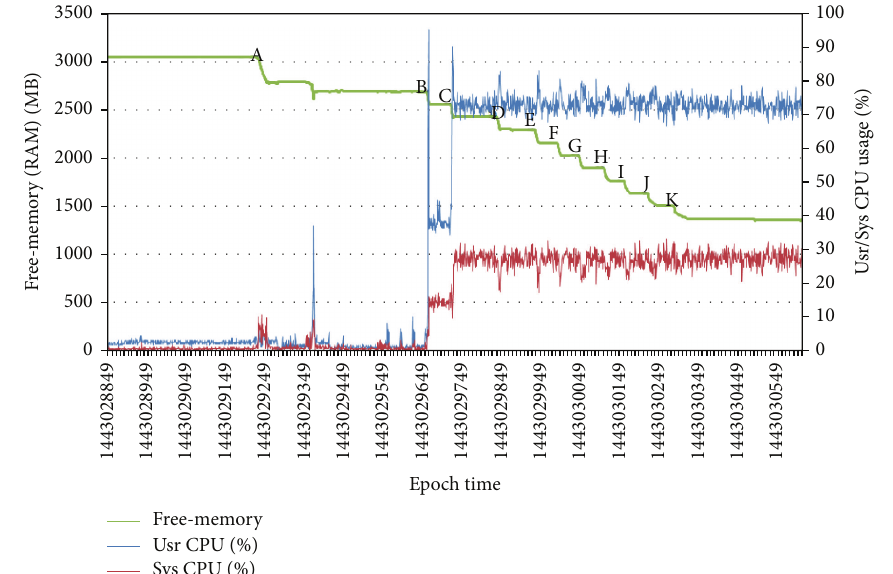
Figure 14: Memory and CPU loading characteristics for the scenario of 10-honeypot container hot spares and subsequent